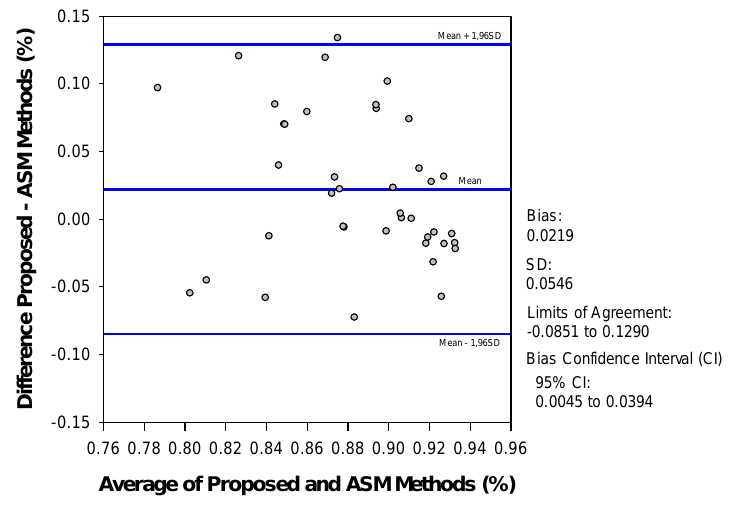
Figure 11. The Bland–Altman figure comparing the best two obtained results (the proposed one and